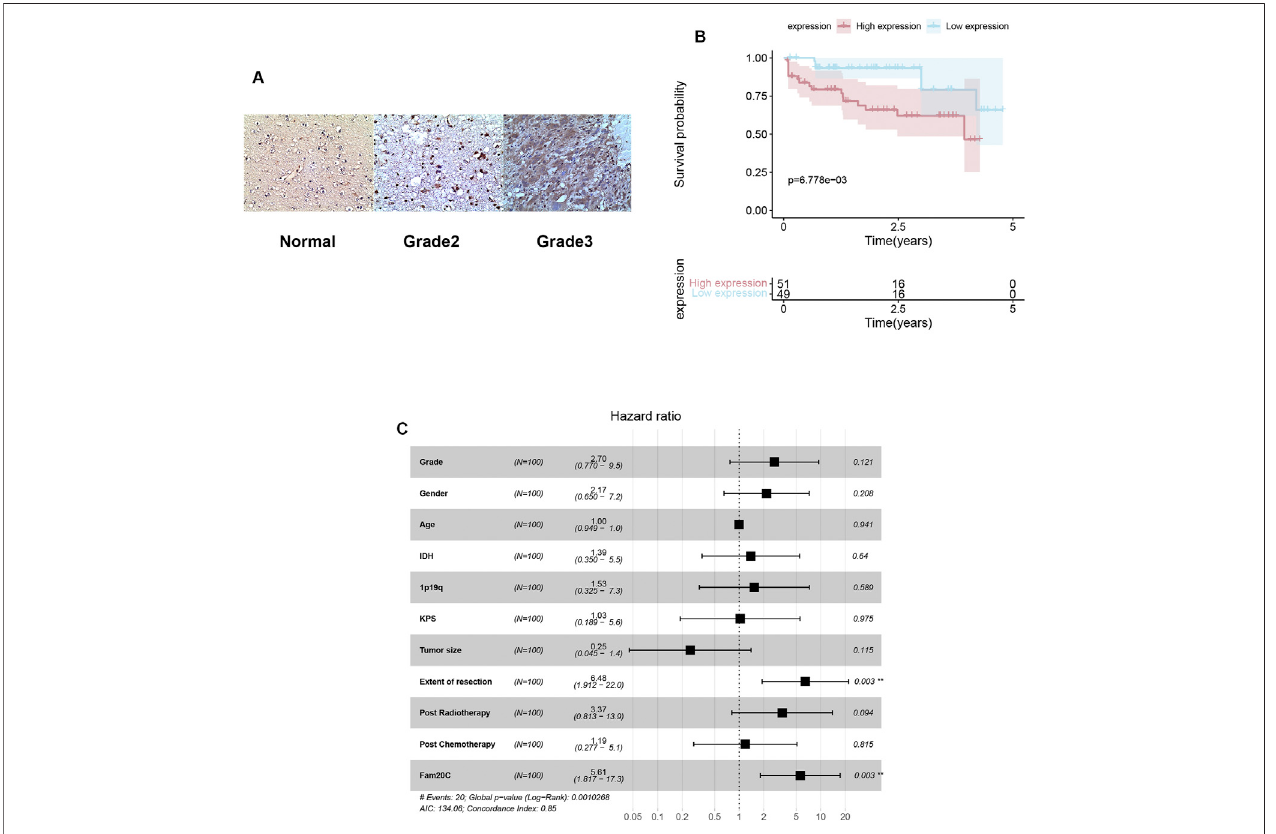
FIGURE6| Expressions,immunohistochemistryandmultivariateCoxanalysisofFam20cinourcohort. (A) Representative fi guresofFAM20Cimmune-staininginourclinical LGGsamples(200X;gradeII: n (cid:1) 60,gradeIII: n (cid:1) 40,normal: n (cid:1) 3); (B) Kaplan – MeiercurveevaluatingthecorrelationbetweenFAM20CproteinexpressionandLGGpatients ’ survival (FAM20C low vs high, low n (cid:1) 51, high n (cid:1) 49, p < 0.001; Log rank test). (C) Multivariate Cox analysis evaluating independently predictive ability of Fam20c for OS.